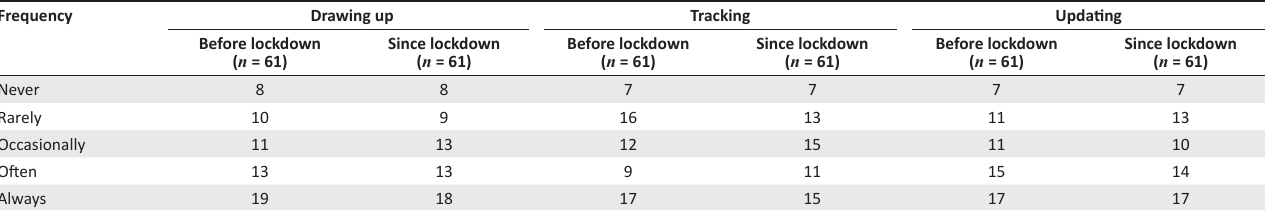
TABLE 4: Budget control